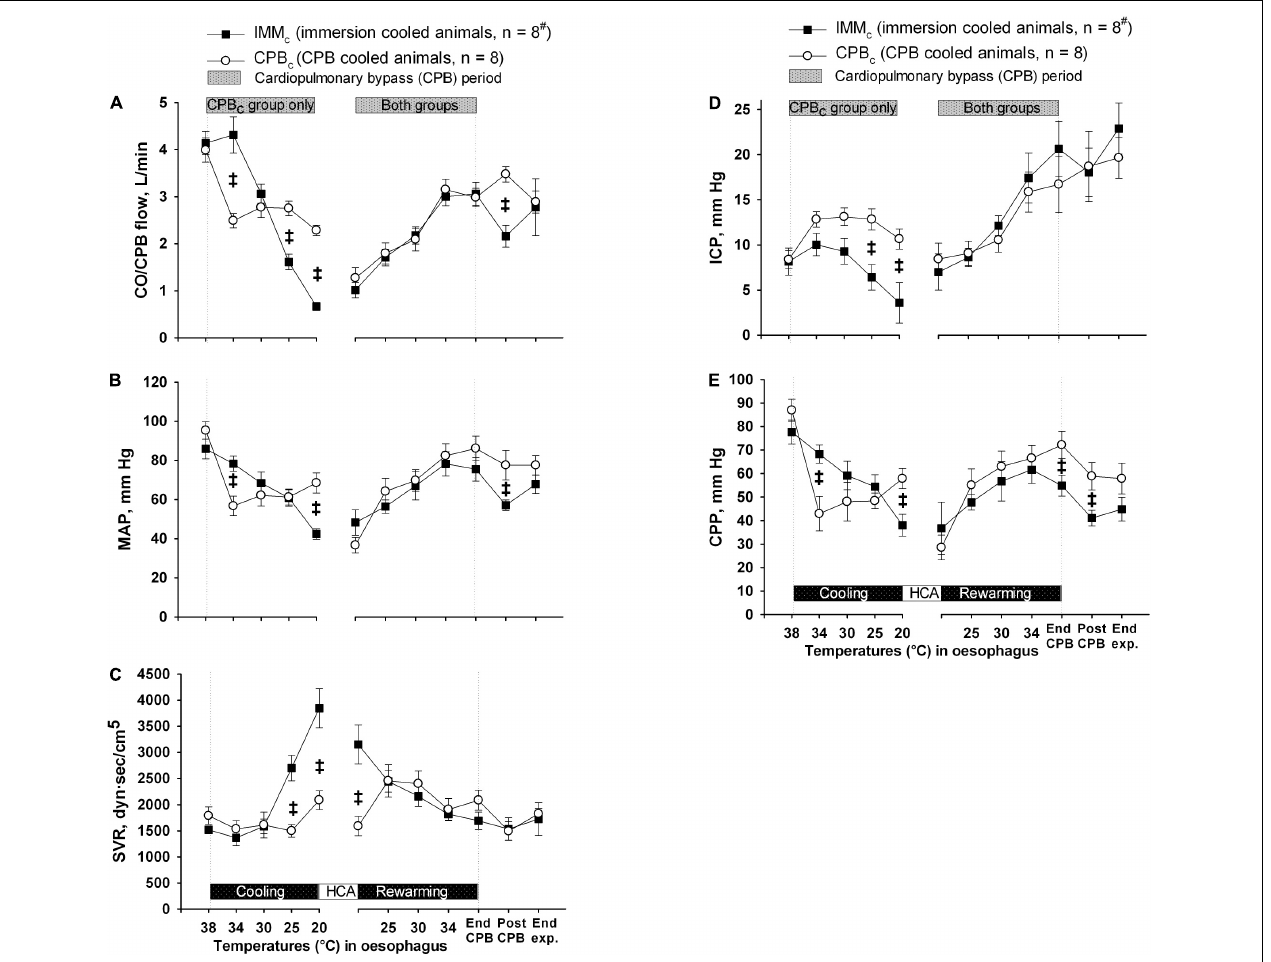
FIGURE 3 | Blood flow and pressures. (A) Cardiac output and CPB flow (CO/CPB flow). (B) Mean arterial pressure (MAP). (C) Systemic vascular resistance (SVR). (D) Intracranial pressure (ICP). (E) Cerebral perfusion pressure (CPP). Data presented as mean and SEM. ‡ Statistically significant difference between groups ( p < 0.05). # n was reduced to 5 animals after termination of CPB (Post CPB) and to 4 animals at end of experiments (End exp.) in IMM c